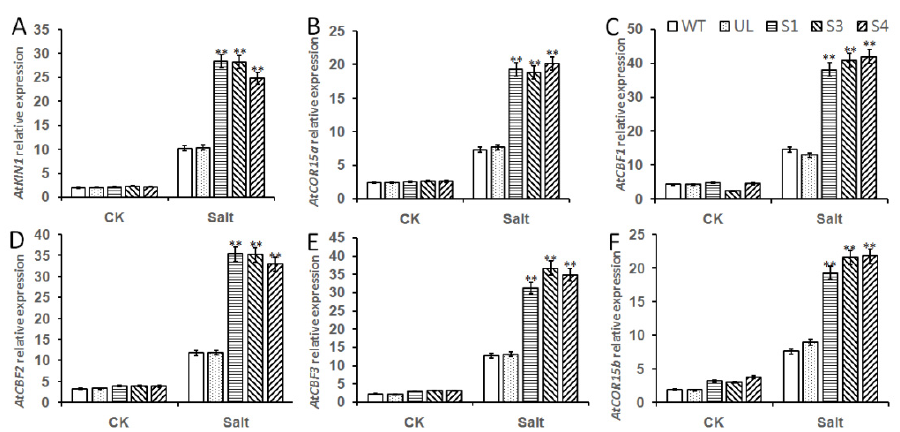
Figure 6. Relative expression levels of salt stress related genes in WT, UL and transgenic Arabidopsis . The relative expression levels of AtK1N1 ( A ), AtCOR15a ( B ), AtCBF1 ( C ), AtCBF2 ( D ), AtCBF3 ( E ) and AtCOR15b ( F ). Data represent means and standard errors of three replicates. Asterisks above columns indicate significant difference compared to that in WT (** p ≤ 0.01).